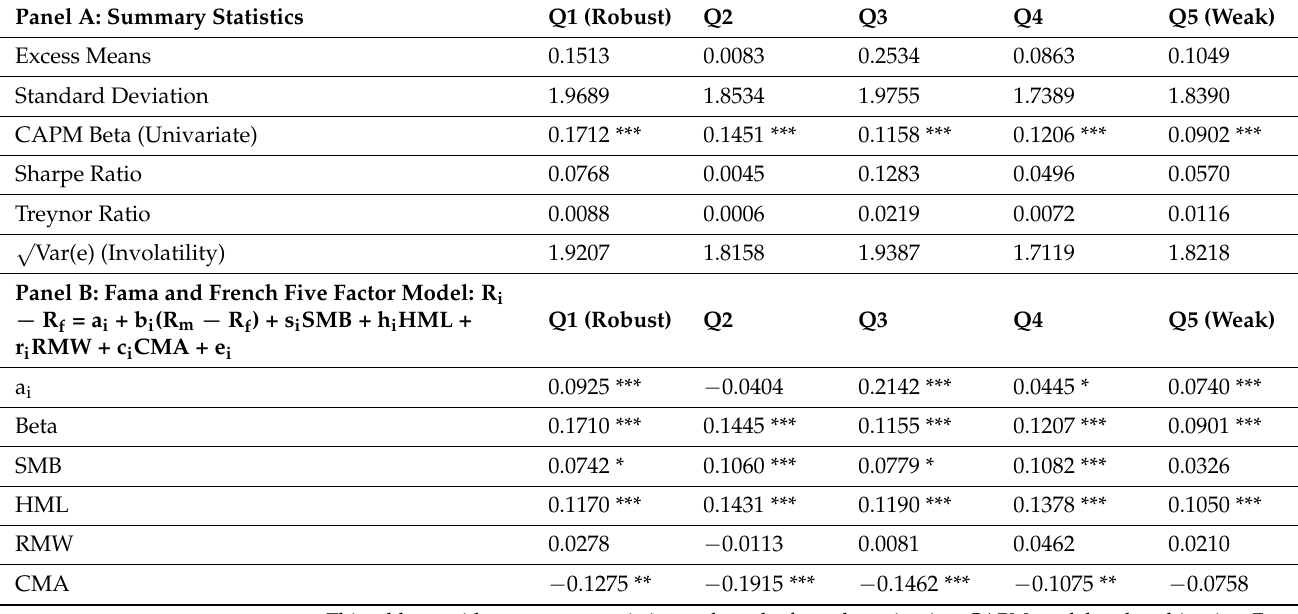
Table 4. Risk measures for Robust and Weak Profitability REIT portfolios (2001–2020).